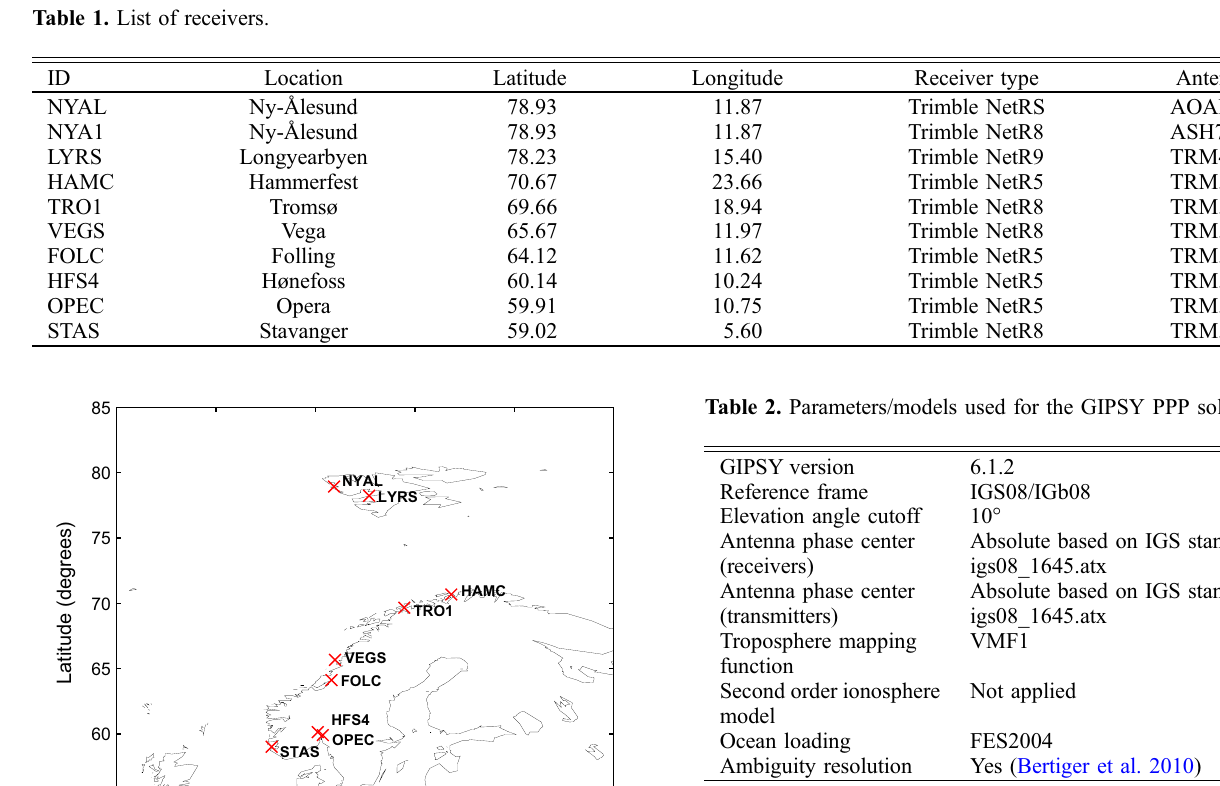
Table 1. List of receivers.